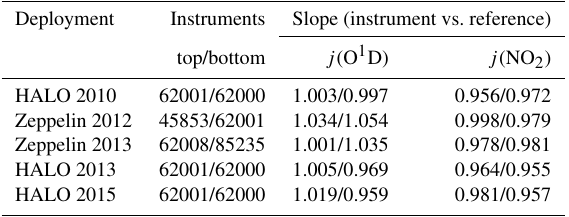
Table 6. Results of ground-based spectroradiometer comparisons associated with contemporary airborne instrument deployments of different CCD-SRs. The numbers are slopes of j (O 1 D) and j (NO 2 ) regression lines based on 2–5-day parallel measurements with a DM-SR